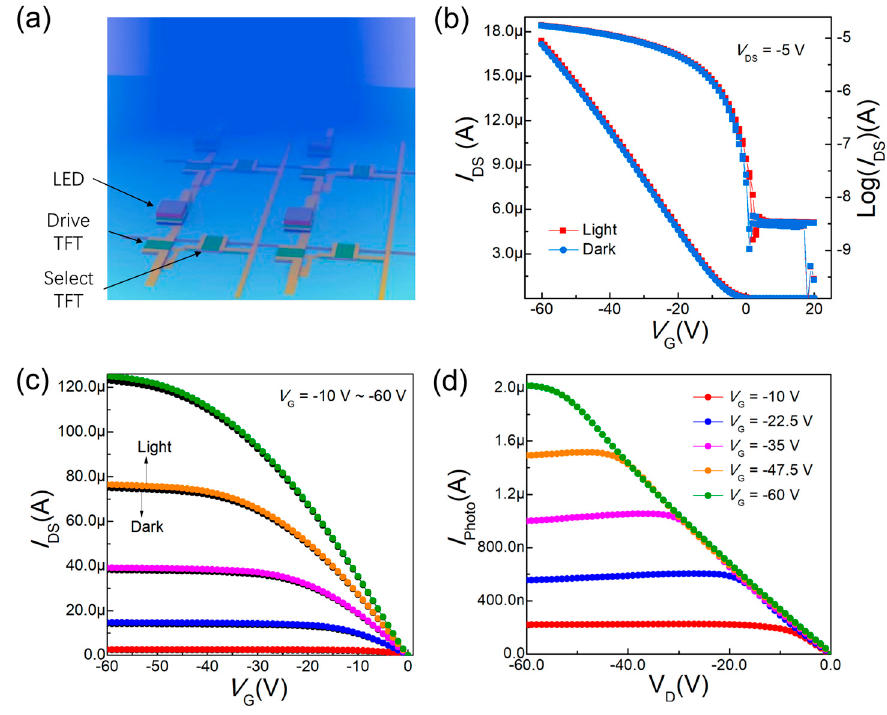
Figure 1. ( a ) Schematic illustration of TFT-LED matrix; ( b ) transfer curve characteristics and ( c ) output characteristics of pentacene TFT measured in dark and illumination; ( d ) photocurrent of the pentacene TFT in the dependence of drain bias.